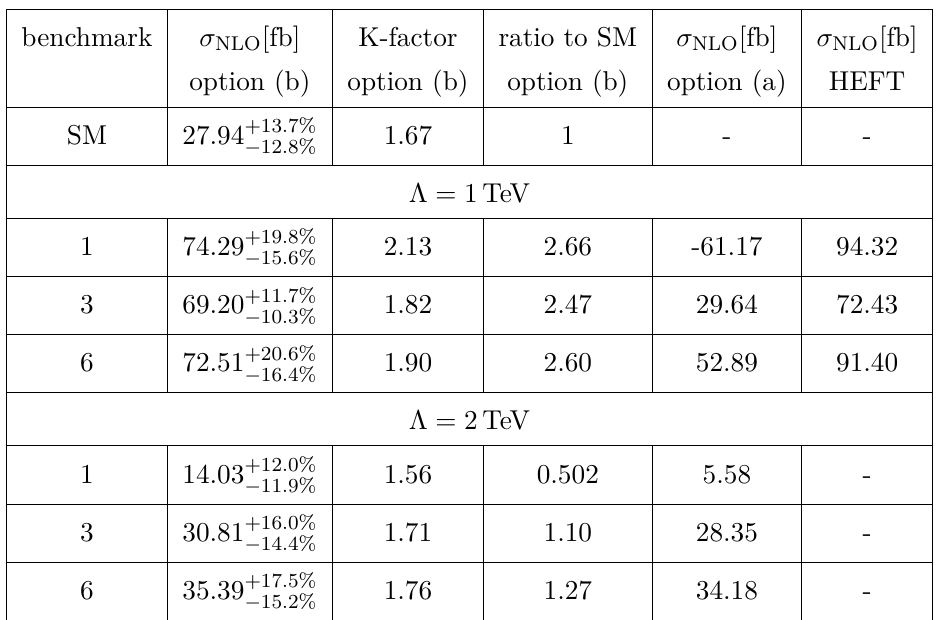
Table 3 . Total cross sections for Higgs-boson pair production at full NLO QCD for three benchmark points and truncation option (b). The total cross sections for truncation option (a) are also given, in order to highlight the difference to the linearised case, as well as the values for HEFT. One can clearly see that truncation option (a) is not a valid option for Λ = 1 TeV, leading to an unphysical cross section. The uncertainties are scale uncertainties based on 3-point scale